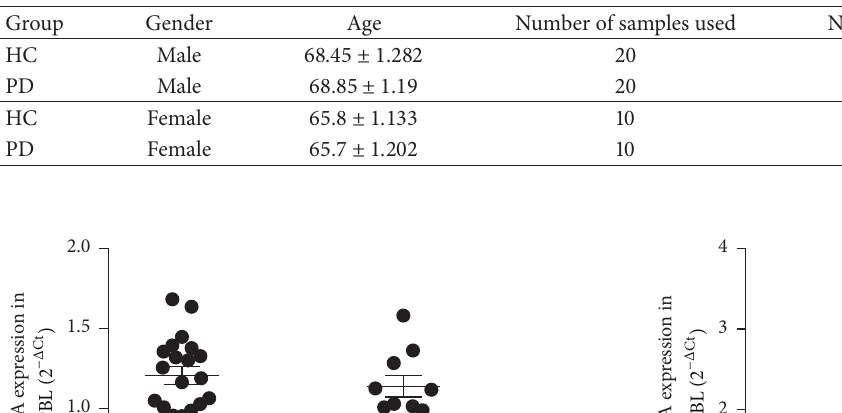
Table 3: NURR1 gene expression versus 𝛽 -actin as internal control in all groups.